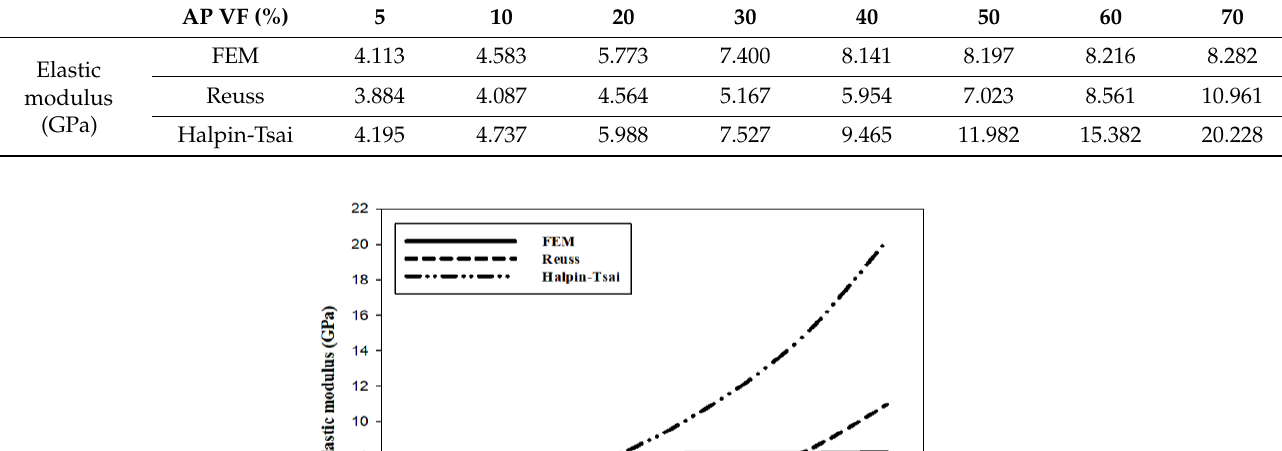
Table 4. FEM and numerical analysis predictions of elastic modulus.